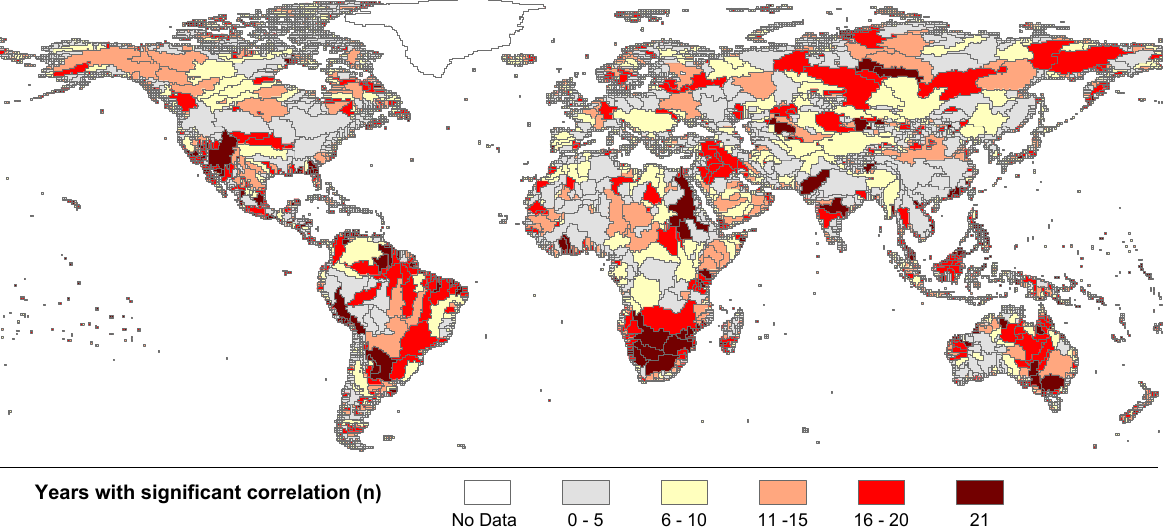
Fig. 6. Number of years ( n) for which the correlation (Pearson’s r) between ln Q max and SOI DJF is statistically significant ( α = 0 . 10), based on 21yr moving windows centred on 1969 to